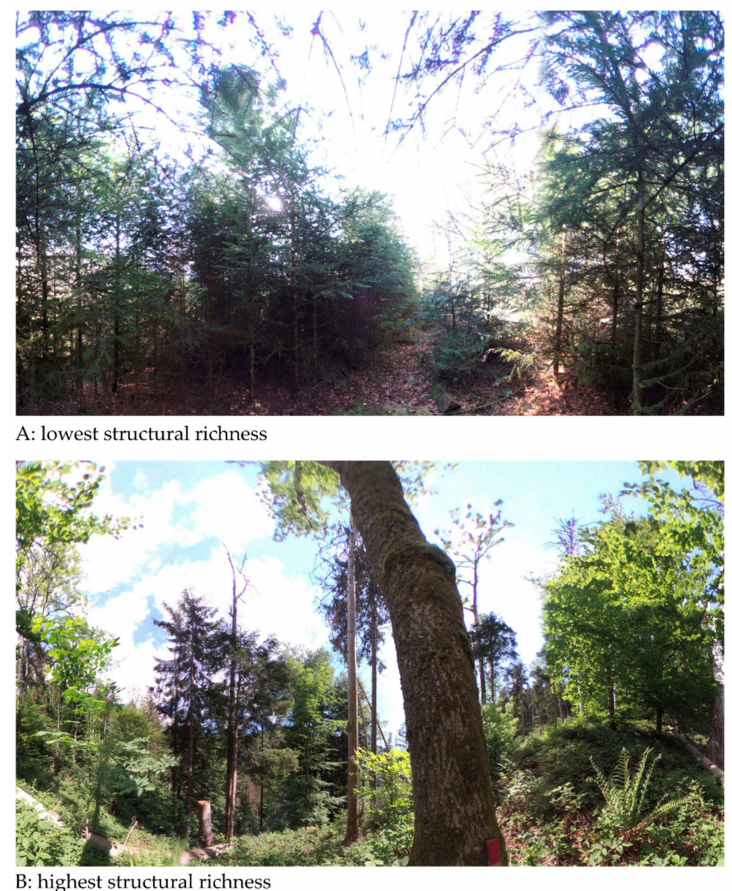
Figure A1. Images with the lowest ( A ) and the highest ( B ) structural richness according to expert